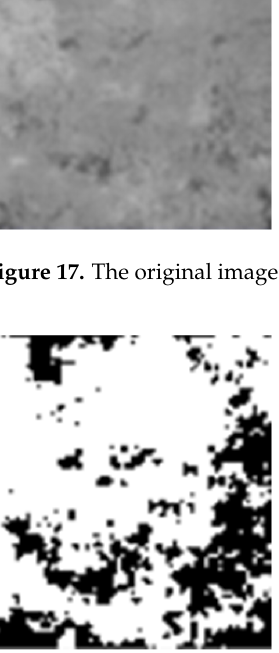
box represents the area of interest.